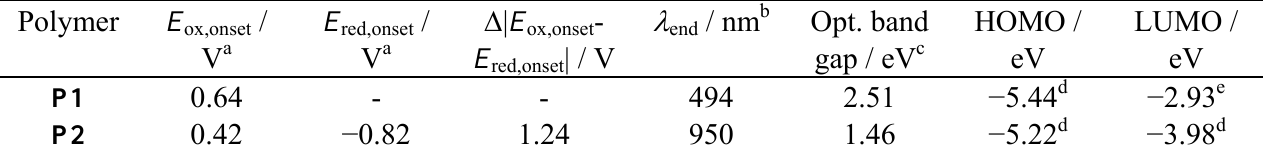
Table 1. Summary of electrochemical and optical measurements of P1 and P2